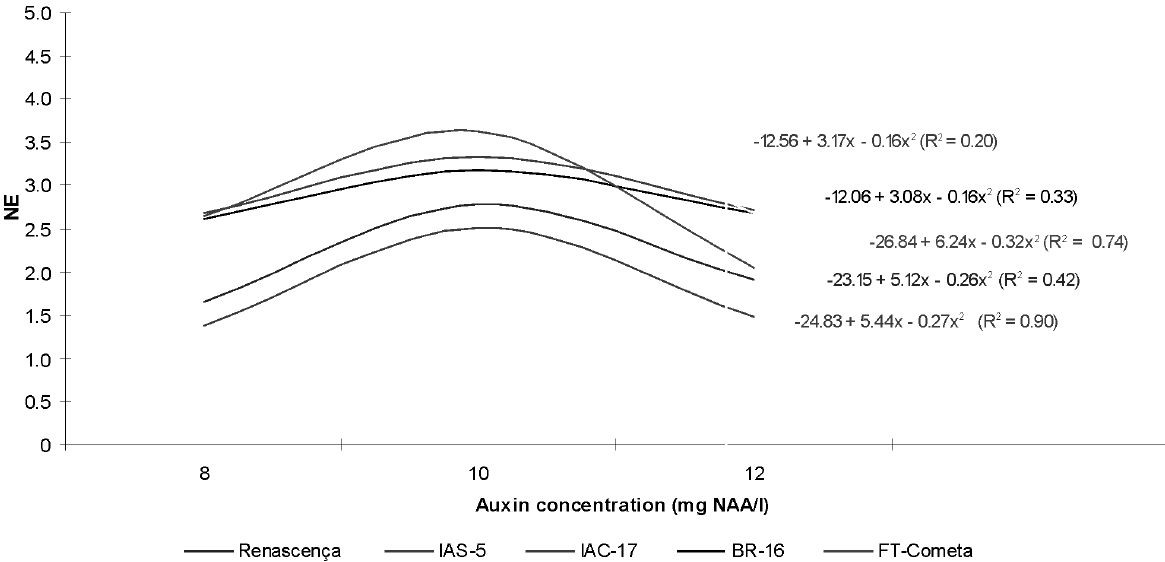
Figure 1 - Regression of the number of somatic embryos (NE) produced by each cultivar as a function of the three auxin concentrations.